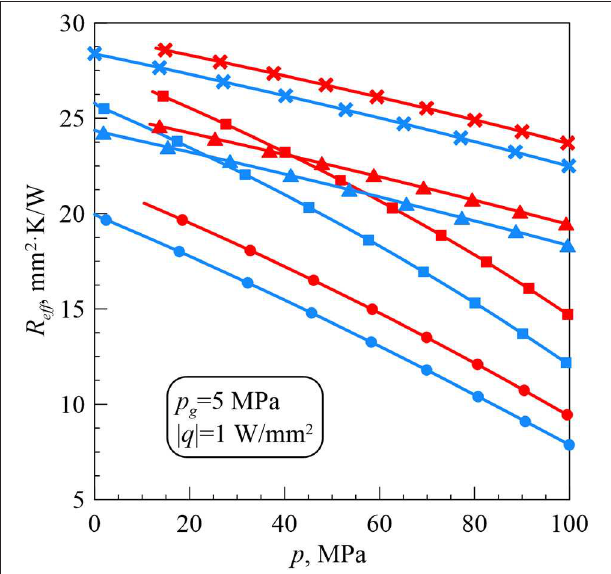
FIGURE 3 | The effective thermal contact resistance R eff vs. the applied pressure p .